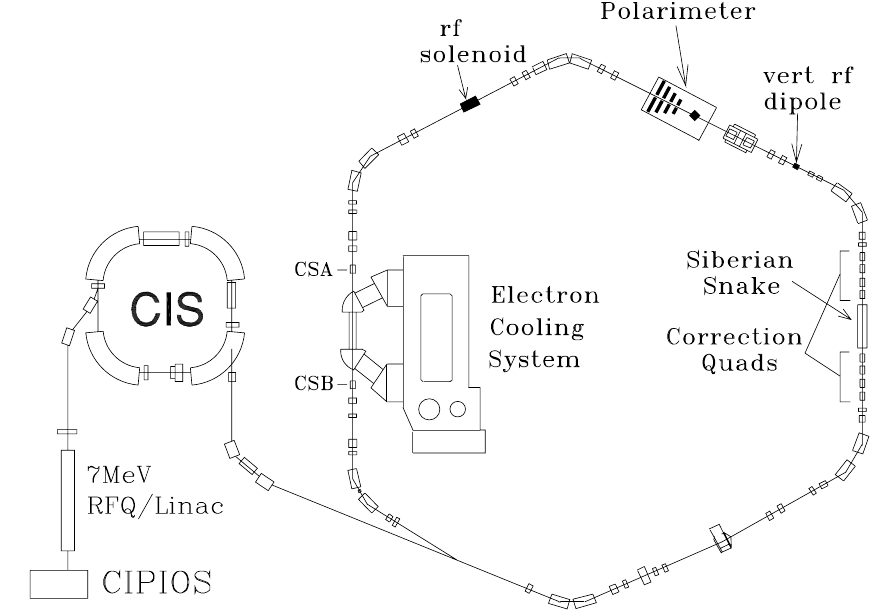
FIG. 1. Layout of the IUCF cooler ring with its new CIS and its new CIPIOS polarized ion source. Also shown in the cooler ring are the rf dipole, the polarimeter, and the Siberian snake which was off.